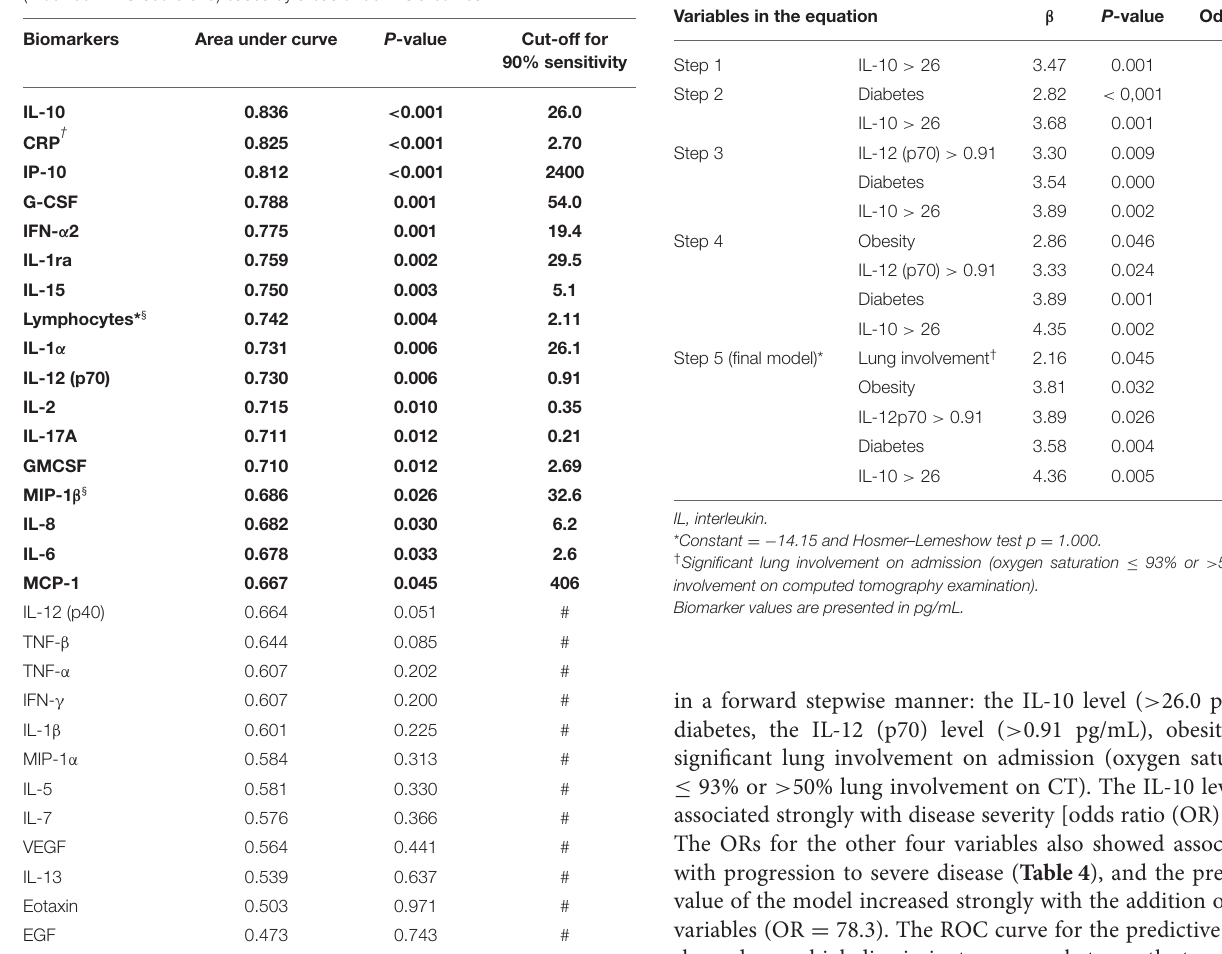
TABLE 3 | Distinction of severe (modified WHO score 6–8) and non-severe (modified WHO score 3–5) cases by areas under ROC curves. Biomarkers